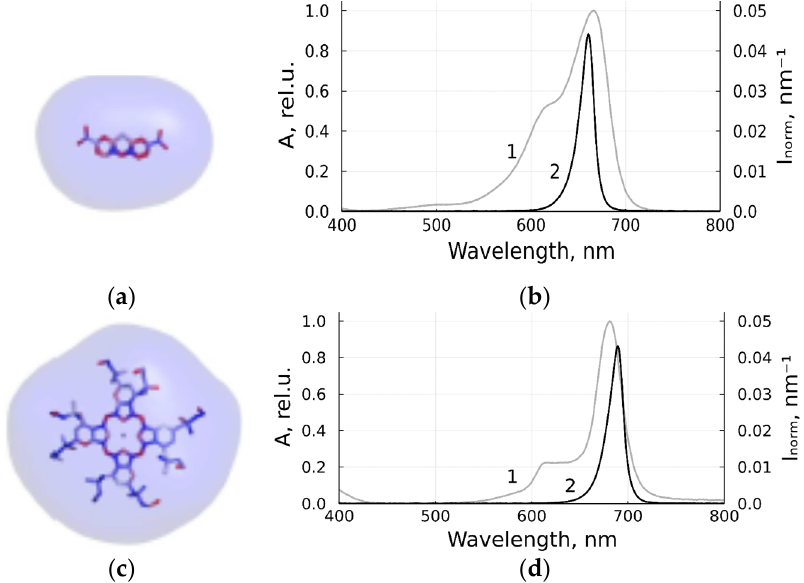
Figure 1. Cationic PSs used in this study and LEDs for their excitation: monocationic MB ( a , b ), octacationic Zn-PcChol 8+ ( c , d ); the stick models of PSs with equipotential electrostatic surfaces colored by red ( − 7 mV) and blue (+7 mV) in accordance with [22] ( a , c ); normalized spectral contours of the absorption bands of PSs (1) and normalized emission spectra of LED sources (2) in accordance with [27] ( b , d ).